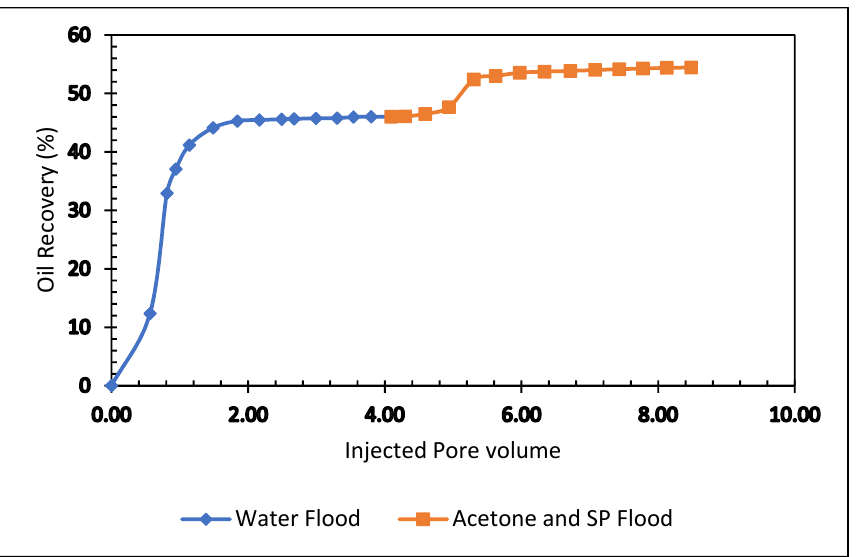
Figure 12. Total oil production from the carbonate core after the brine, acetone, and SP blend, followed by a post-flood with brine.